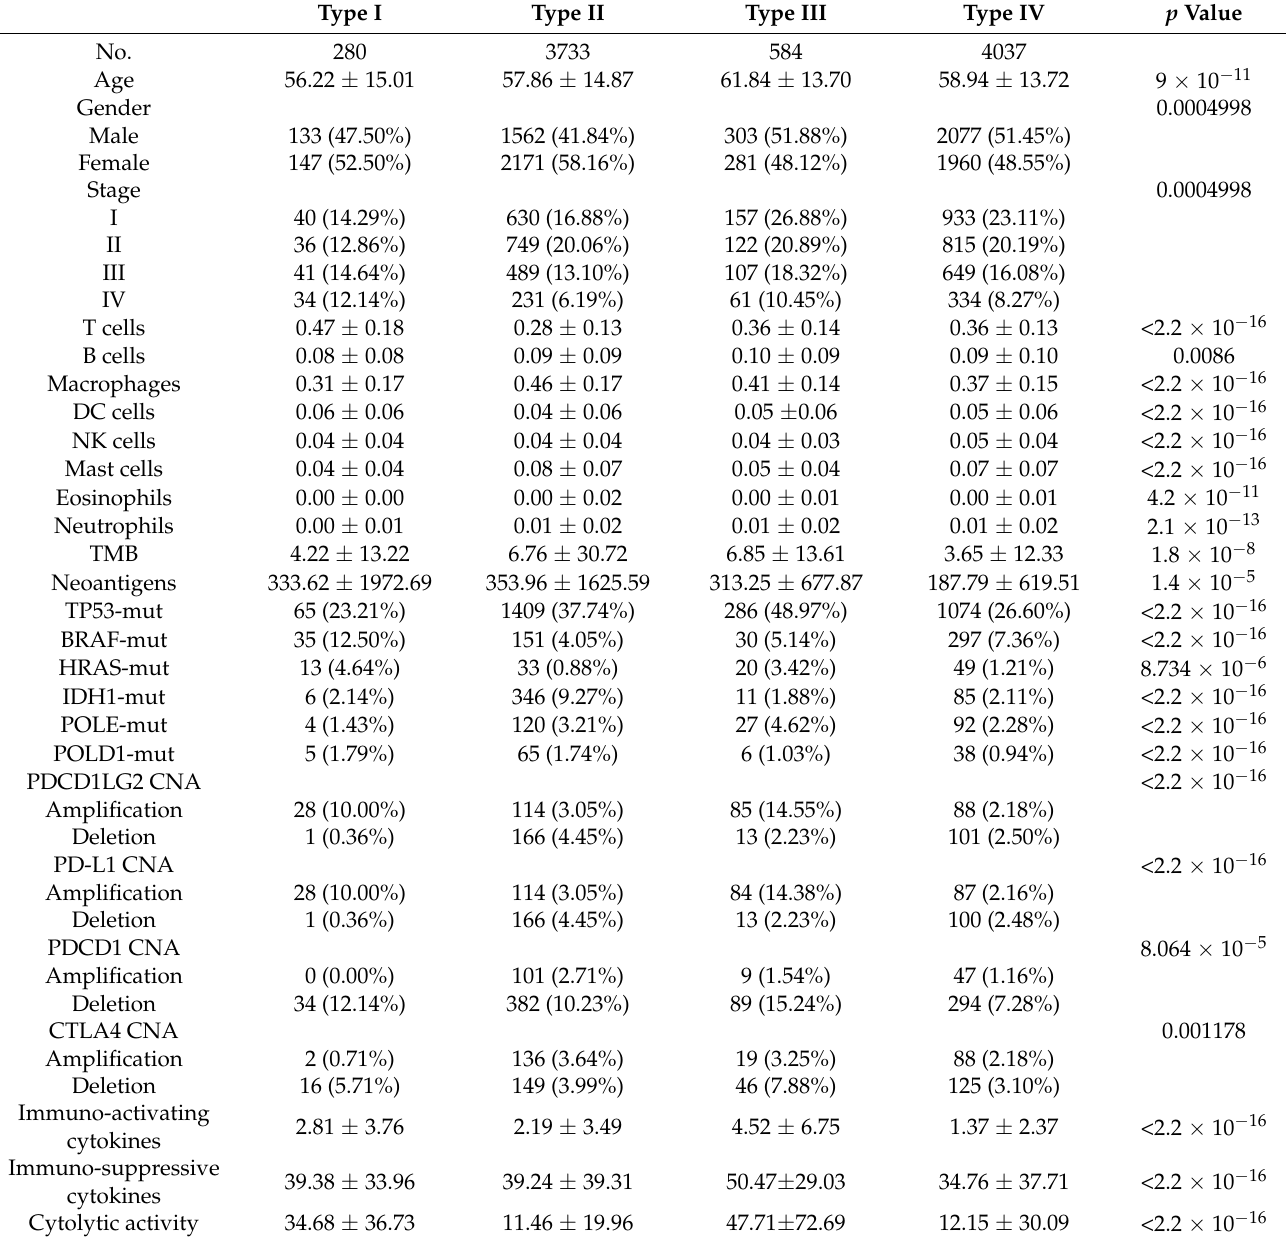
Table 2. Clinical, pathological, and molecular characteristics of pan-cancer, according to tumor immune microenvironment subtypes based on programmed death ligand 1 (PD-L1) expression and tumor infiltrating lymphocyte